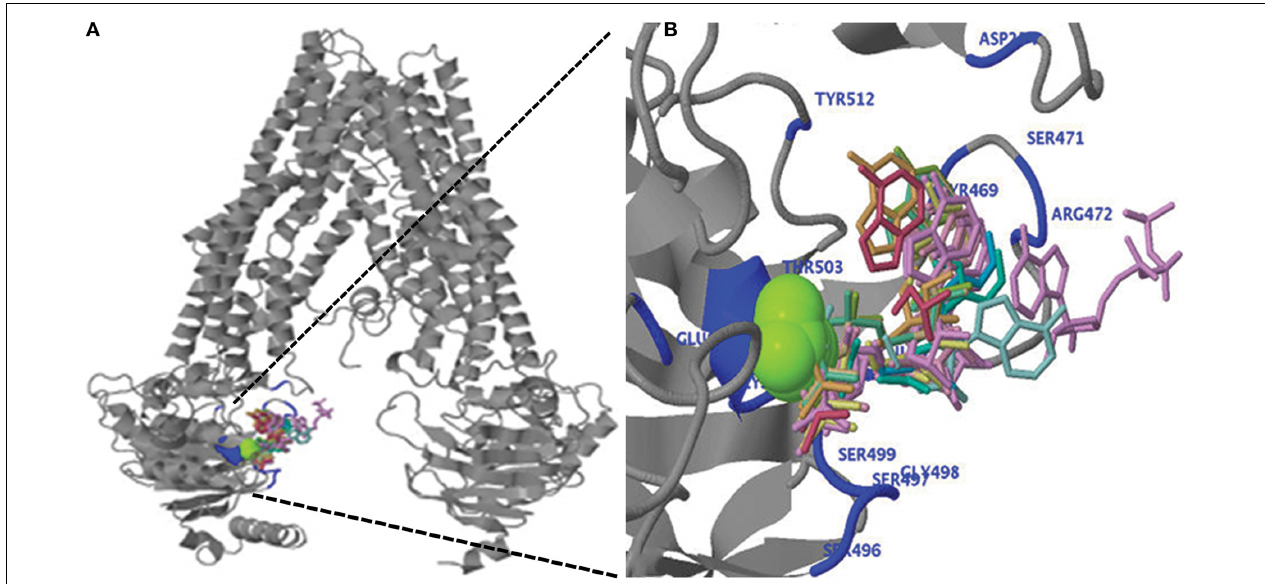
FIGURE 5 | (A) Predicted three-dimensional structure of the ZmABCB1. (B) Ligand binding of magnesium ion (green), ADP and ATP (wired structure) as well as residues involved in binding (blue) are shown at the N-terminal region of ZmABCB1.